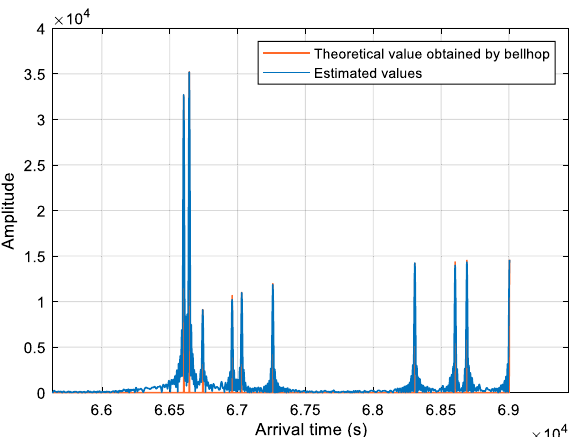
Fig. 10 Impulse response: theoretical and estimated values